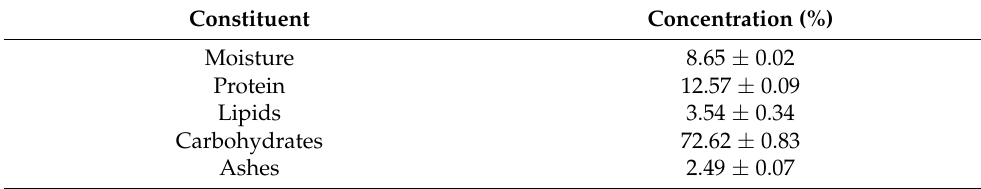
Figure 1. PSR after oil extraction ( a ) and milling for use in fermentations ( b ). Table 2. Proximate composition of